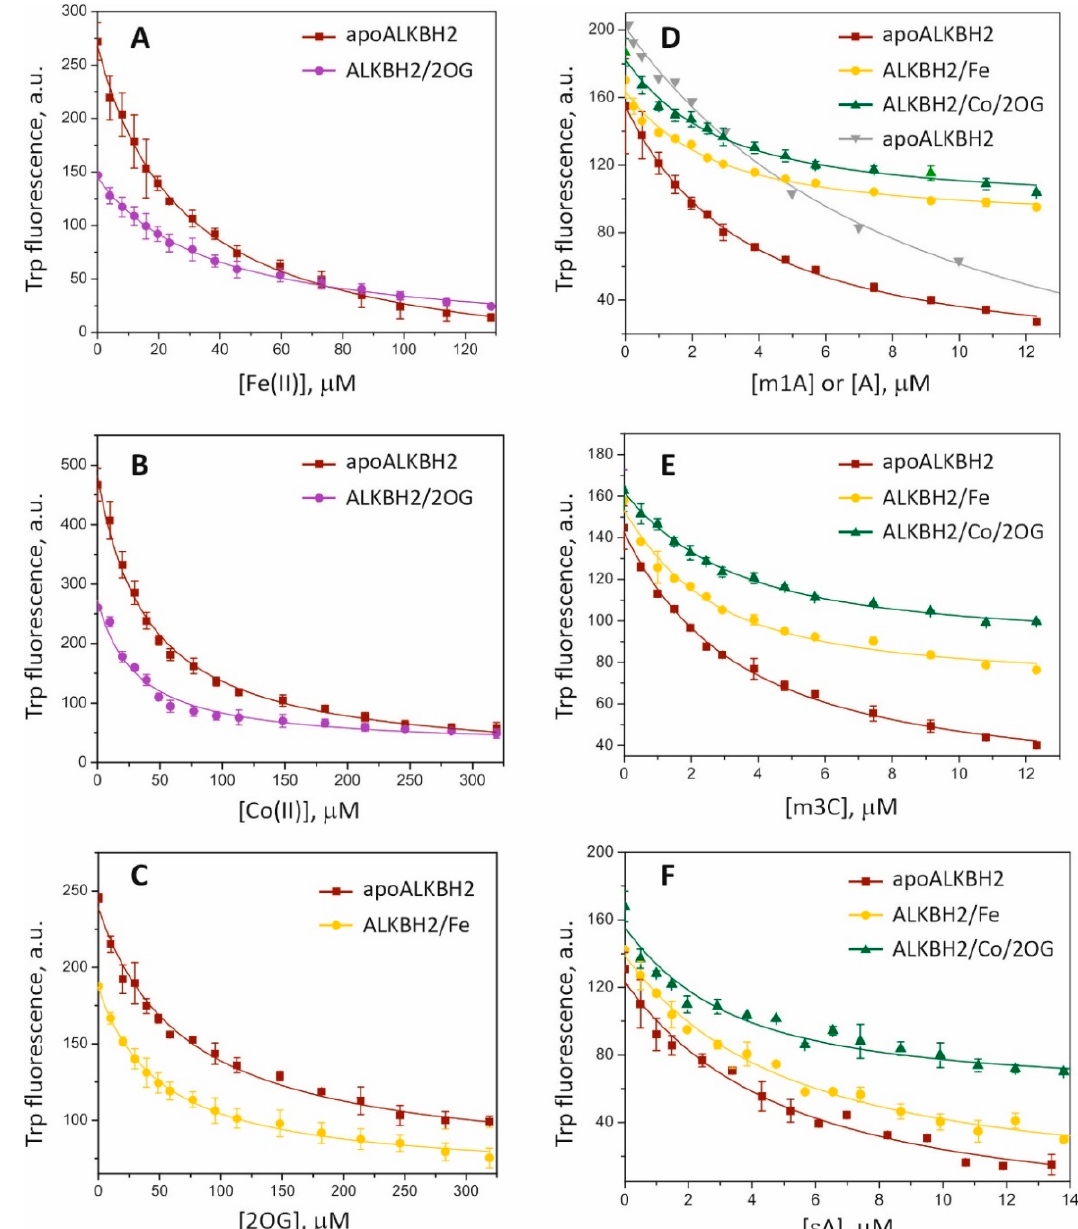
Figure 2. Equilibrium binding of ALKBH2 to metal ions, 2OG, or damaged DNA. Trp fluorescence of the enzyme is shown as a function of concentration of a metal ion ( A , B ), 2OG ( C ), or DNA substrate ( D – F ). Gray triangles in panel D indicate titration of the ALKBH2/Fe(II)/2OG complex with a 15 nt undamaged ODN containing A instead of m1A. The enzyme concentration was 1 μ M. The concentrations of Fe(II), Co(II), and 2OG within preformed ALKBH2/Me(II) or ALKBH2/Me(II)/2OG complexes were 40 μ M, 100 μ M, and 1 mM, respectively. Fluorescent titration of apoALKBH2 was carried out in the presence of 2 mM EDTA. Experimental data points were fitted to a single-site binding model. Each trace represents the average of three independent assays. In the figures, for better presentation, the curves were manually moved apart.